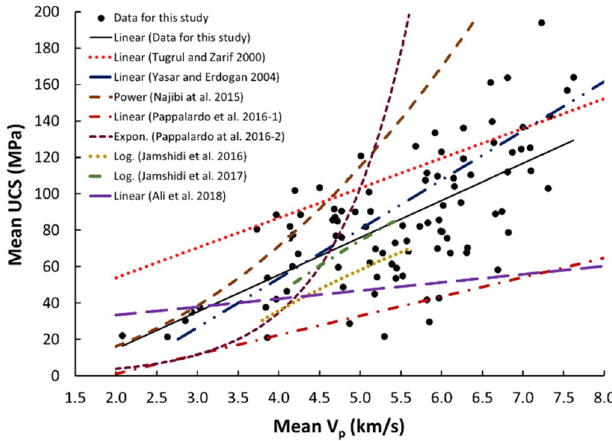
Figure 13. Comparison of results obtained in this study with those obtained in previous studies; V p versus UCS of limestone.